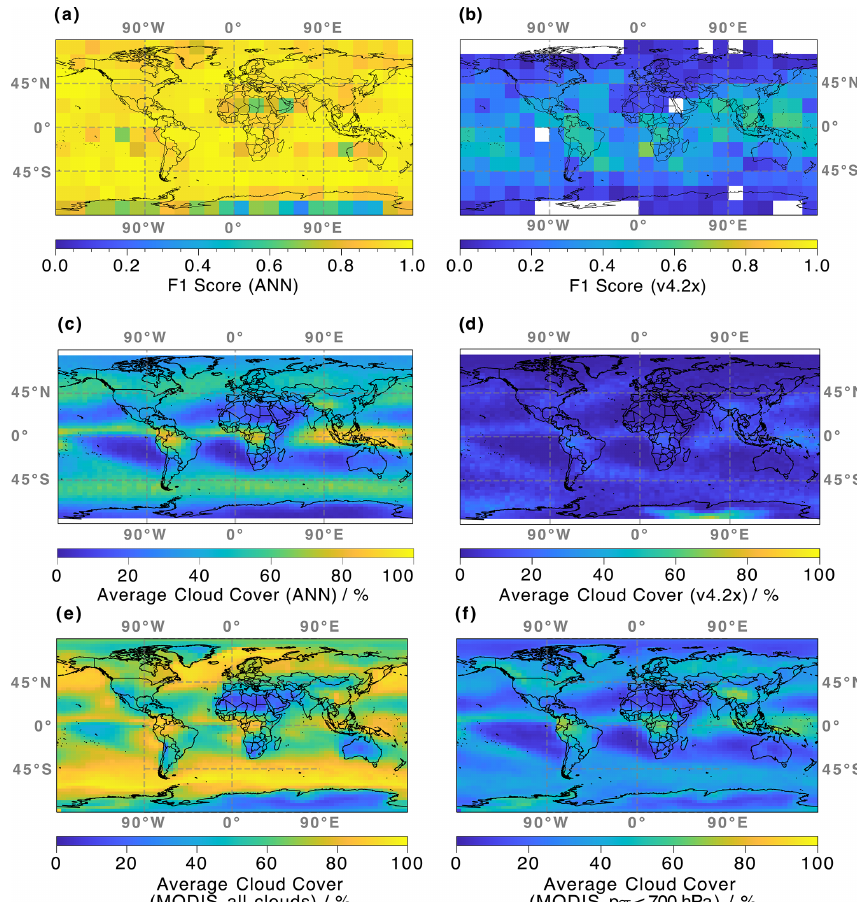
Figure 7. (a) Latitudinal and longitudinal dependence of the performance of the ANN algorithm, determined by the F1 score for binary clas- sifications. Observations and actual cloudiness flags are provided by the colocated MLS–MODIS data set; only profiles from the validation and training data set are considered. (b) Same as (a) but for the current v4.2x cloud flag. (c) Average global cloud cover derived from MLS brightness temperature observations and the weights determined from the trained ANN. All MLS observations sampled between 2015 and 2019 are represented. (d) Same as (c) but for the current v4.2x cloud flag. (e) Same as (c) but from Aqua MODIS observations sampled in 2019. (f) Same as (e) but with retrieved cloud top pressure <